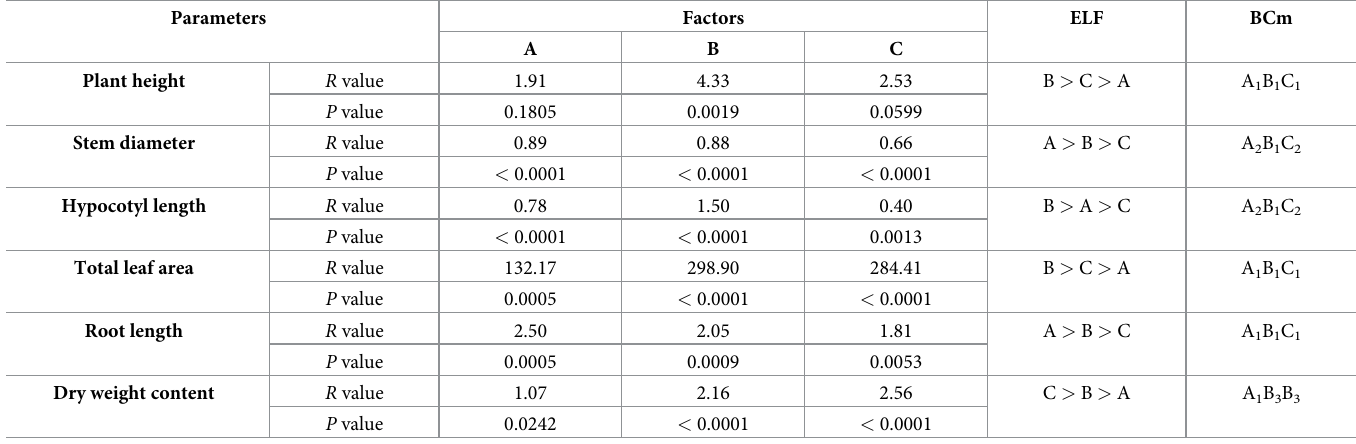
Range value (R)–the range of difference between the maximum and minimum average; (P-value)–ANOVA analysis of variance; ELF–The most influential level factors on the parameter gradually; BCm–The best level combination for each parameter.